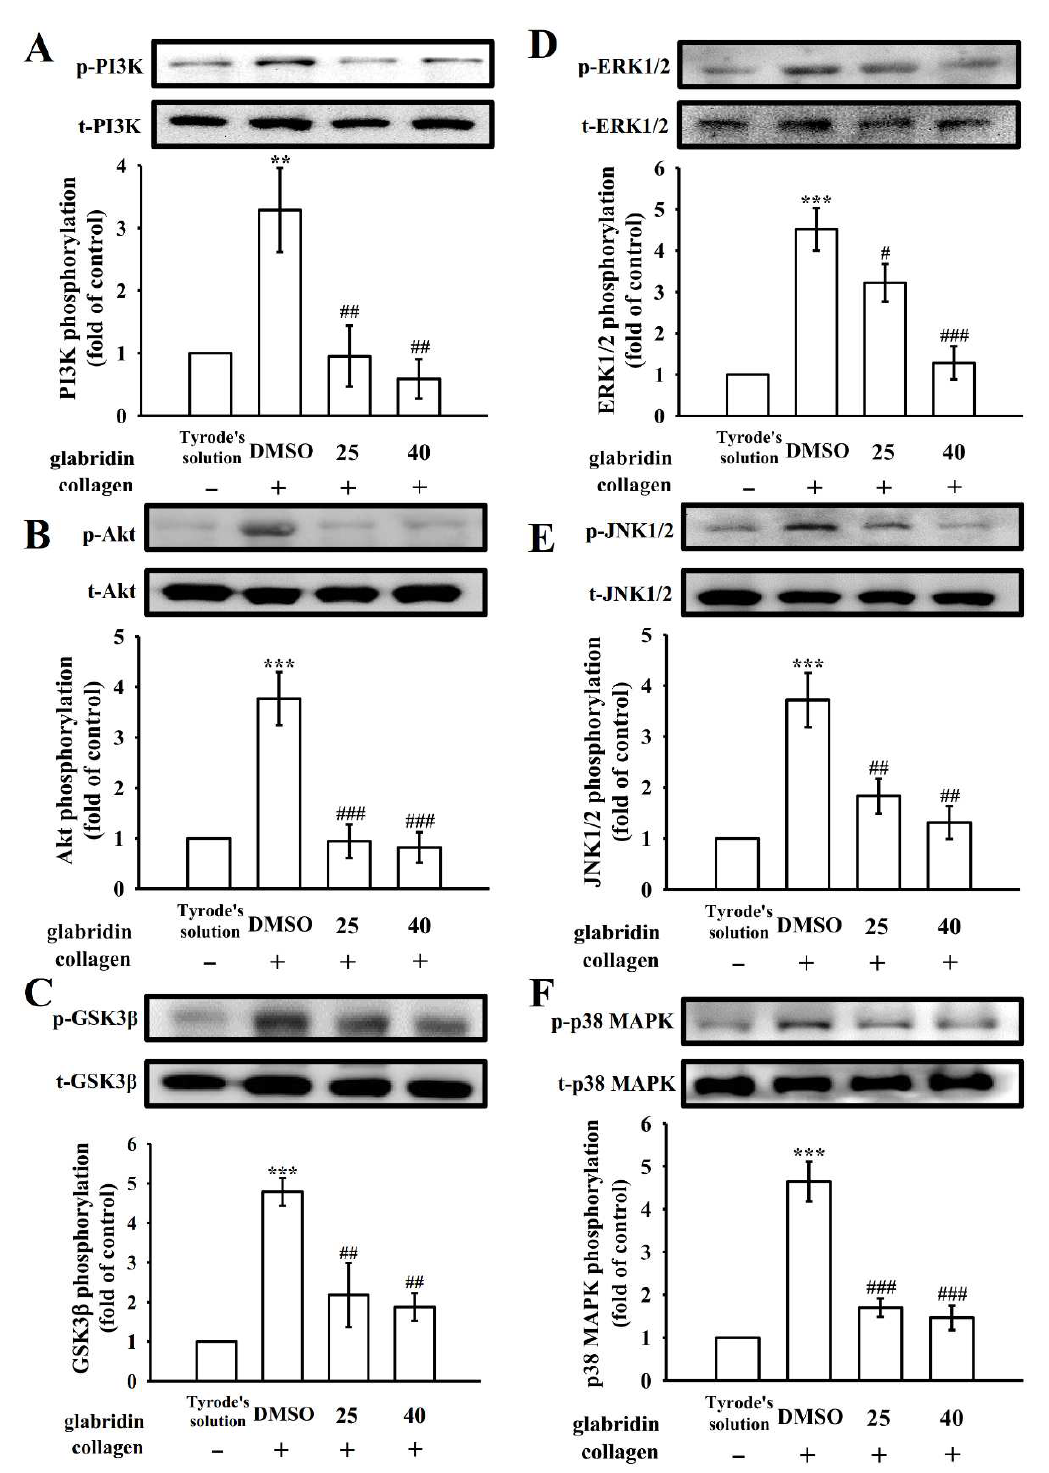
Figure 4. Regulatory activity of glabridin on phosphoinositide 3-kinase (PI3K)/Akt/glycogen synthase kinase-3β (GSK3β) and mitogen-activated protein kinase (MAPK) pathways in platelets. Washed platelets were preincubated with DMSO (0.1%) or glabridin (25 and 40 μM) and treated with collagen (1 μg/mL) for the immunoblotting of ( A ) PI3K, ( B ) Akt, ( C ) GSK3β, ( D ) ERK1/2, ( E ) JNK1/2, and ( F ) p38 MAPK. Data are shown as the mean ± standard error of the mean (n = 4). ** p < 0.01 and *** p < 0.001 vs. resting platelets (in Tyrode’s solution); # p < 0.05, ## p < 0.01, and ### p < 0.001 vs. 0.1% DMSO + collagen group.